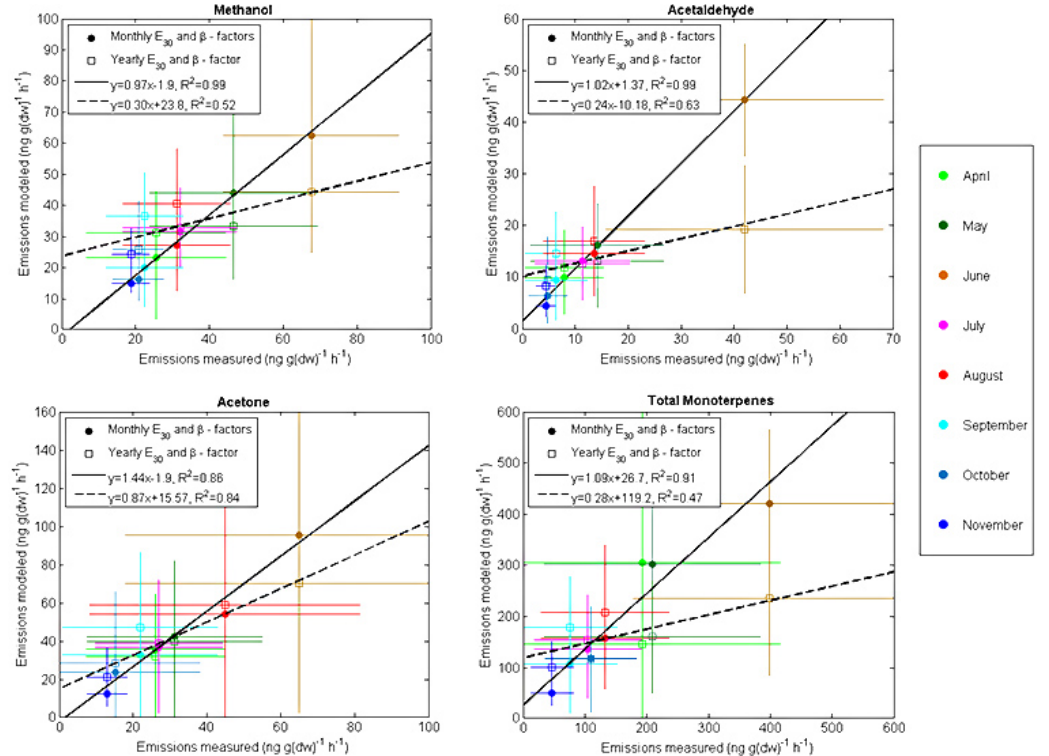
Figure 7. Comparison between measured and modelled (Eq. 6) temperature-dependent emissions for methanol, acetaldehyde, acetone and total monoterpenes. The modelled emissions that are illustrated by open squares have been calculated by using the complete data set ( N =16200) for the derivation of E 30 and β factor (Table 2). The modelled emissions which are shown as filled squares have been cal- culated by using the respective monthly values of E 30 and β factor. The use of monthly E 30 and β factors substantially improve the fitting between the measurements and simulations, while the use of yearly values for these parameters strongly underestimates the